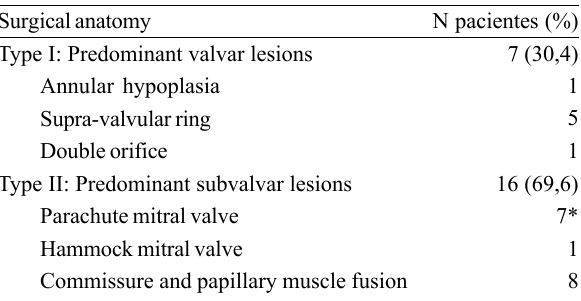
Table 4. Carpentier’s classification of congenital mitral stenosis [8]